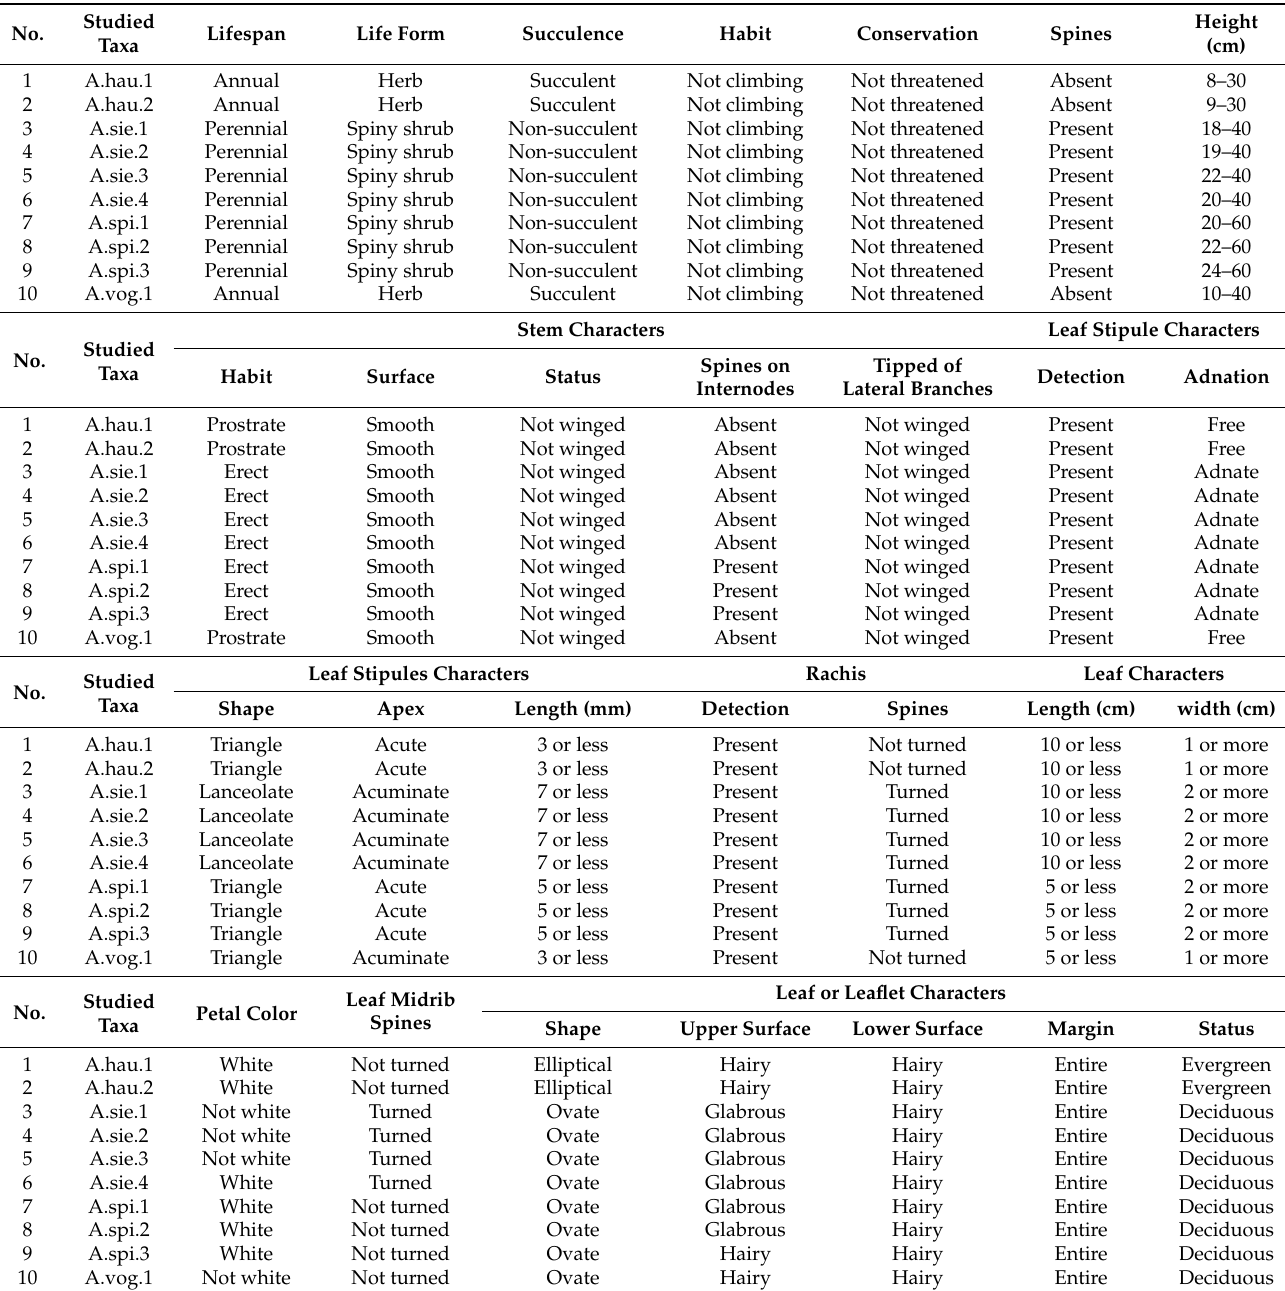
Table 4. Description of morphological characters of all studied taxa after